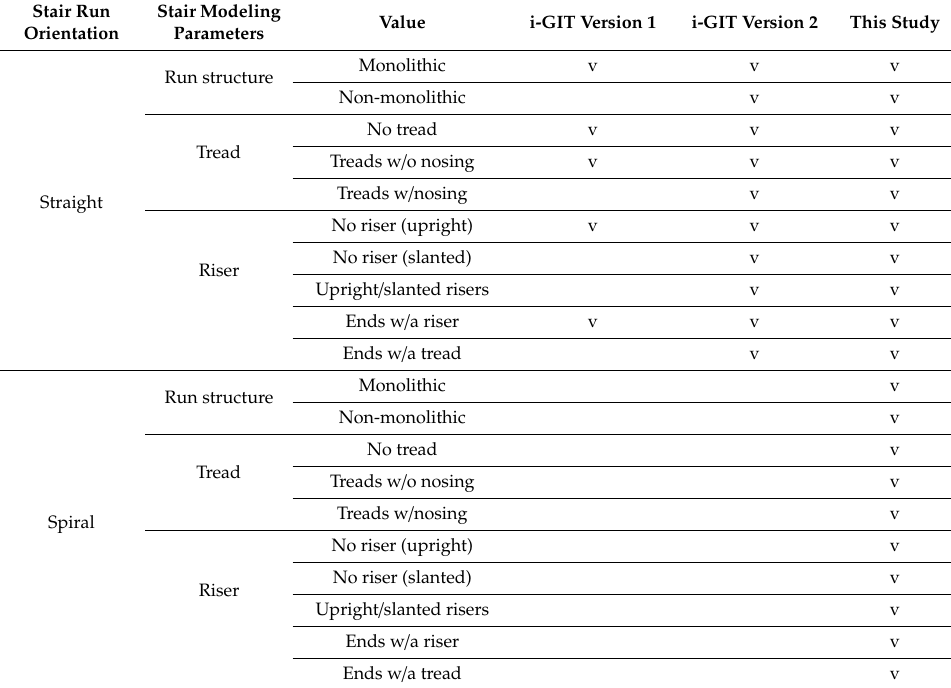
Figure 9. Stair runs ending with ( a ) a riser or ( b ) a tread. Table 1. Comparisons of how each algorithm supports different stair run orientations and modeling parameters.